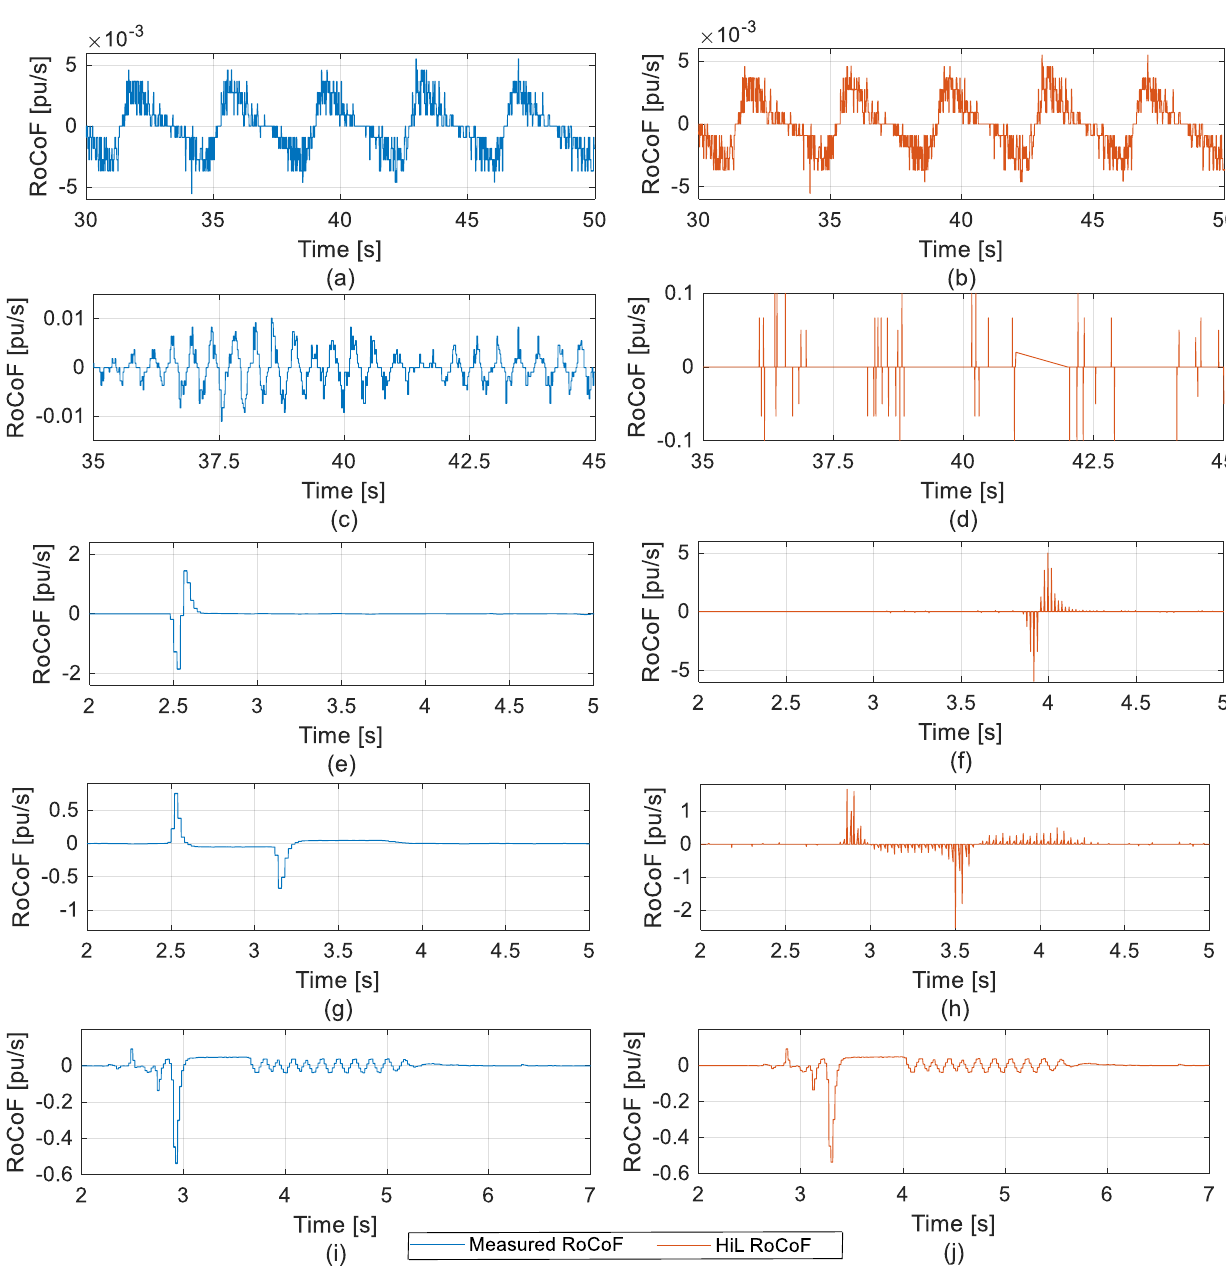
Figure 8. Comparison of the normalized measured frequency (blue) with the normalized frequency modelled in the hard- ware-in-the-loop test (orange) for scenario 1 ( a ), scenario 2 ( b ), scenario 4 ( c ), scenario 7 ( d ), scenario 8 ( e ), and scenario 10 ( f ).